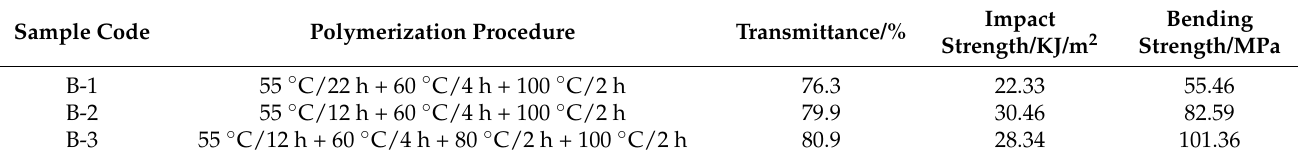
Table 2. The properties of metallized acrylic containing both Gd and Pb.